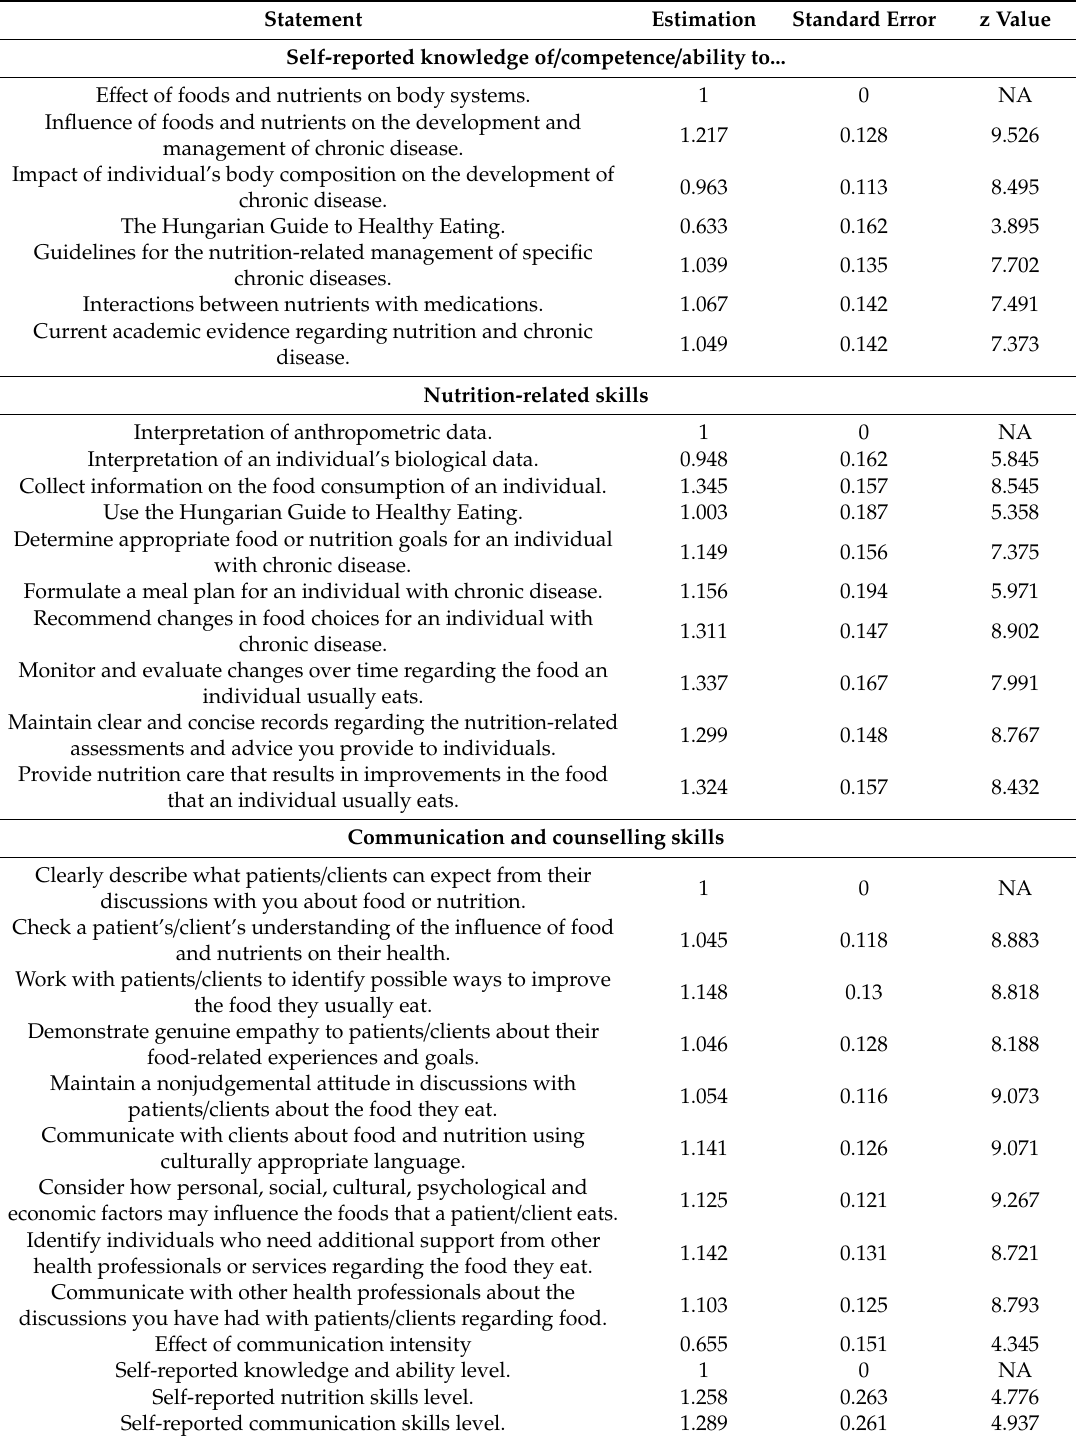
Results of the structural equation model, without taking into consideration the e ff ective / measurable nutrition-related knowledge (z crit = 1.96 at p = 0.05). Model-fitting parameters: p = 0.9, goodness of fit index = 0.95, adjusted goodness of fit index = 0.91 and comparative fit index